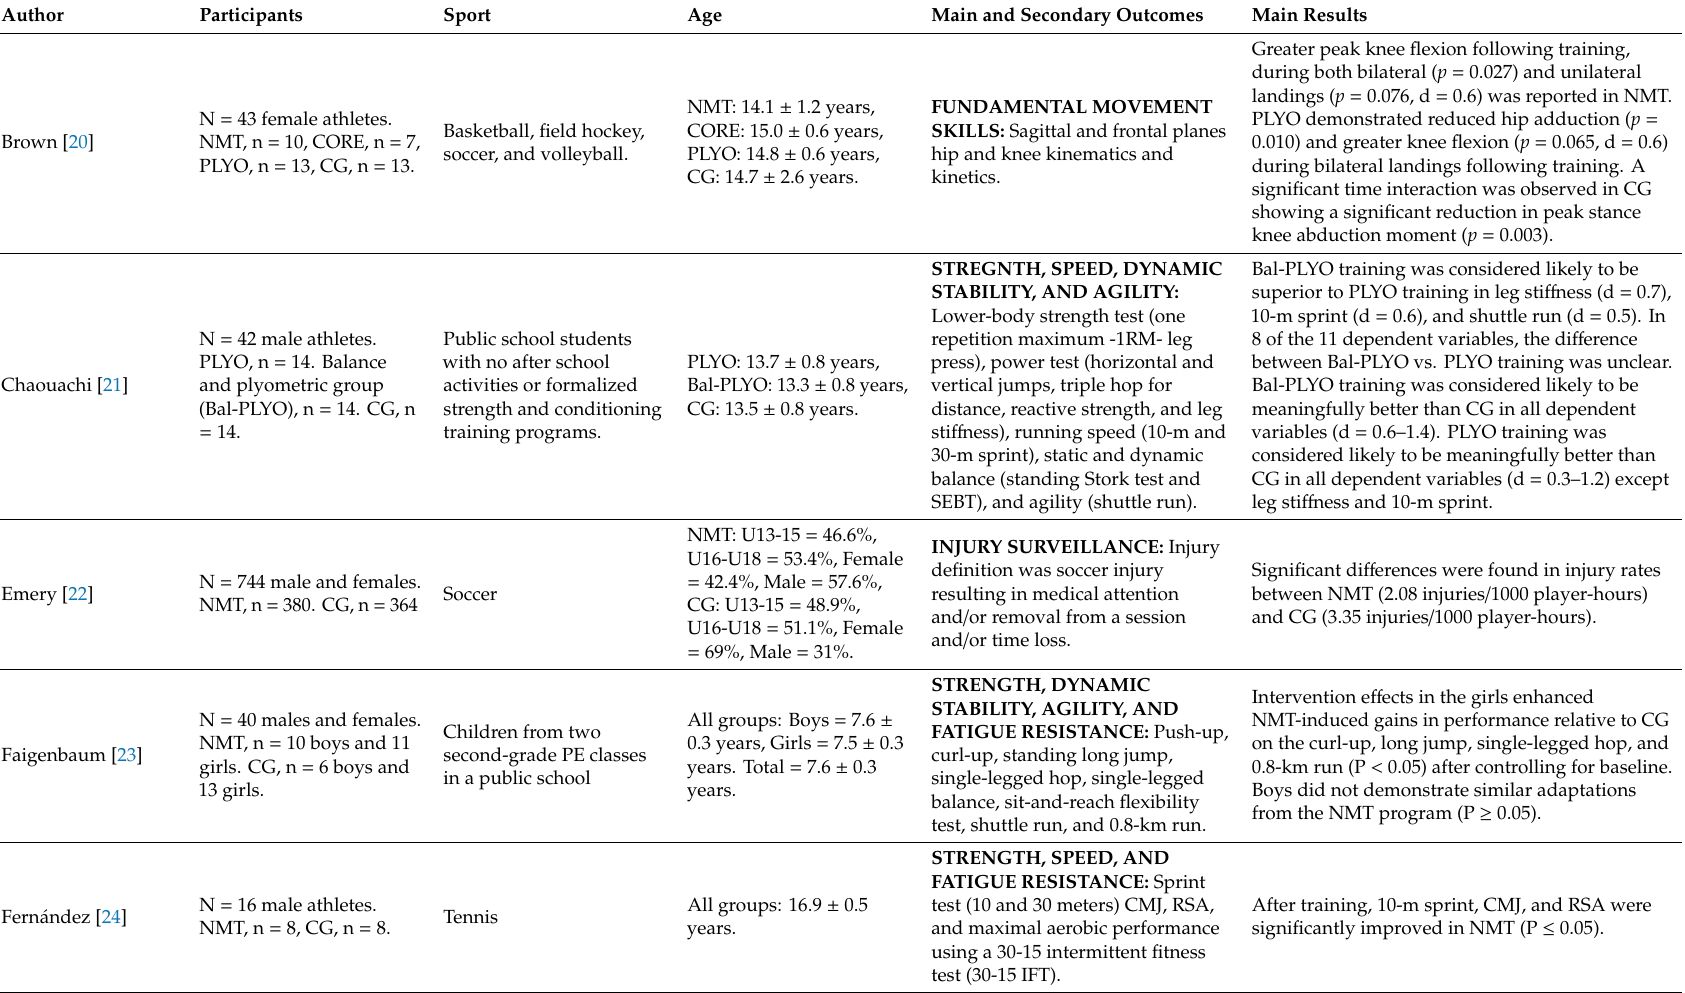
Table 2. Characteristics of the included